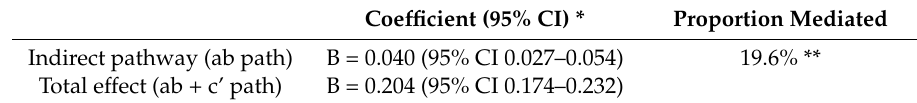
Table 5. Mediating effect of BCAAs on the association of FLI with incident type 2 diabetes.